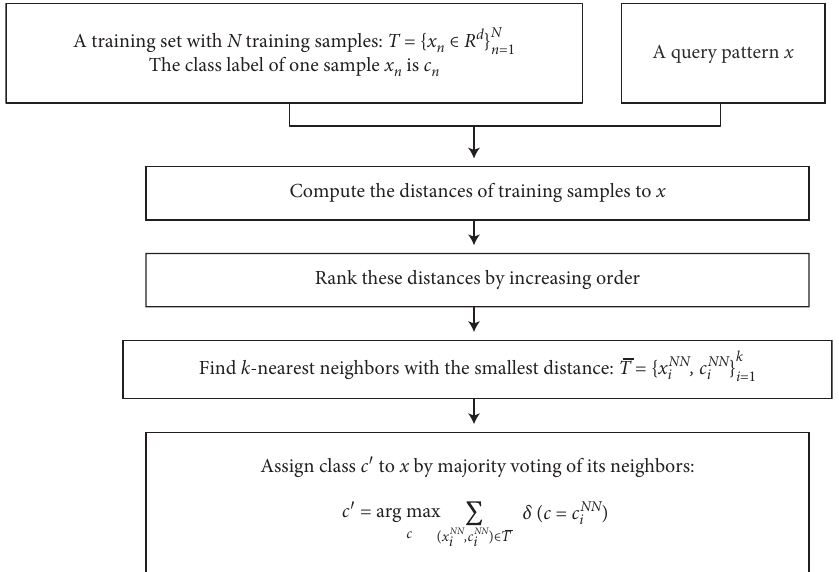
Figure 1: KNN algorithm implementation